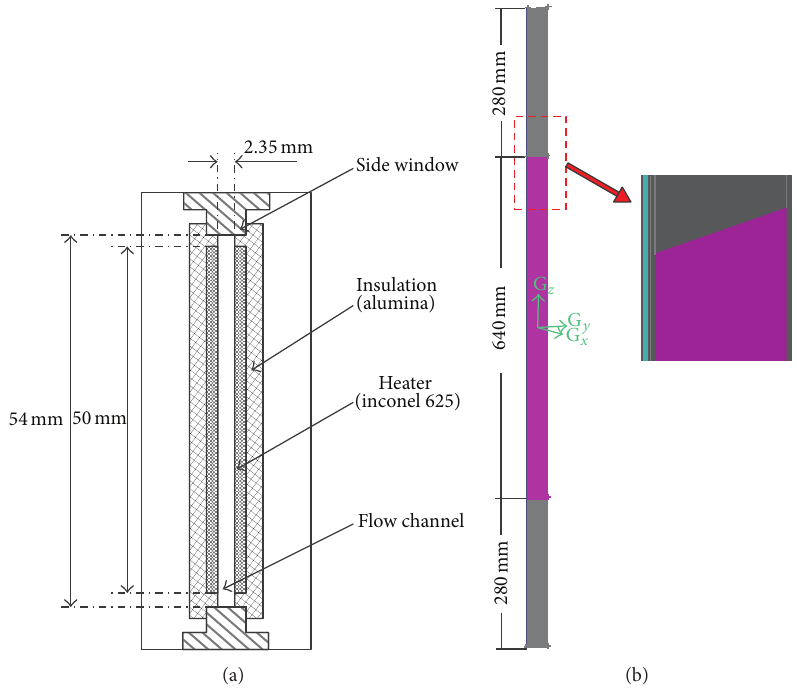
Figure 4: (a) Schematic drawing of the Jo et al.’s [18] experiment and (b) CFD calculation model.